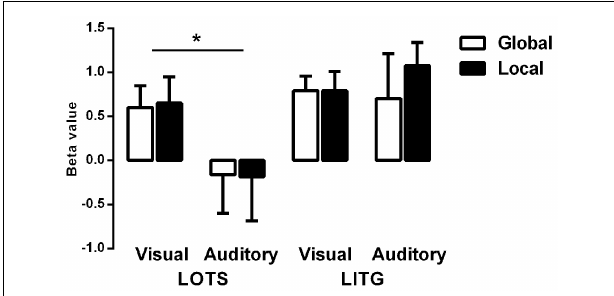
FIGURE 4 | Average Beta values for each ROI and for each condition. LOTS, left occipitotemporal sulcus; LITG, left inferior temporal gyrus. ∗ p <